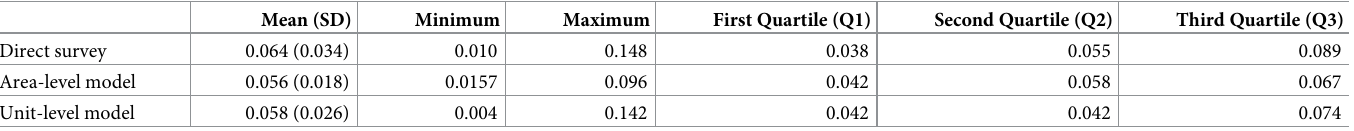
Table 2. Summary of district-level HIV prevalence estimates in